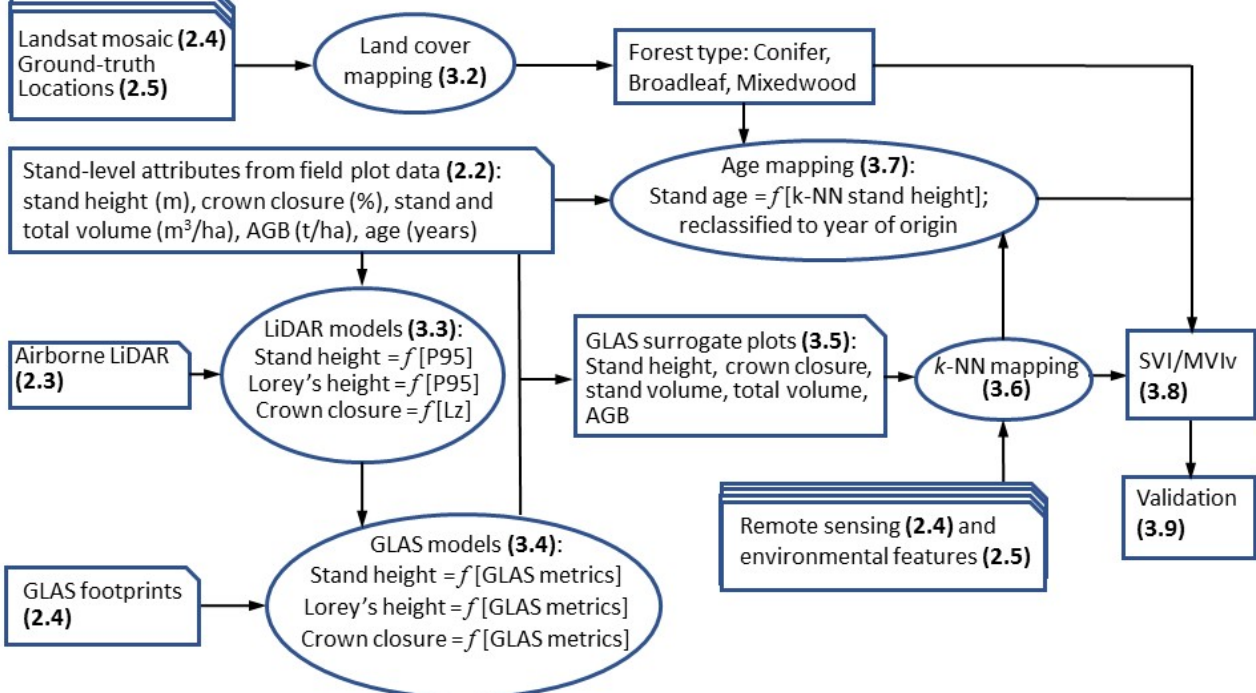
Figure 2. Flowchart of the materials and methods in this study, with reference to the relevant subsections in brackets. Notched rectangles represent inputs, ellipses represent models or processes, and rectangles represent outputs.